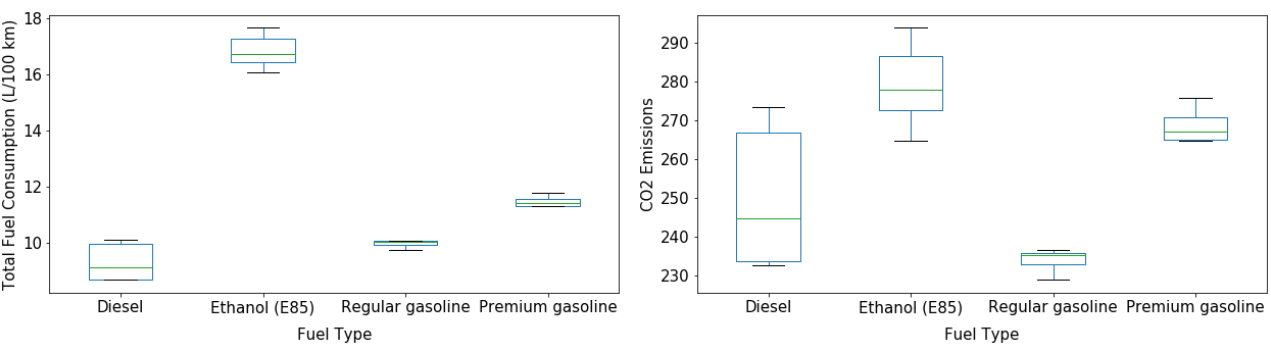
Figure 11. Total fuel consumption and emissions of each fuel type over